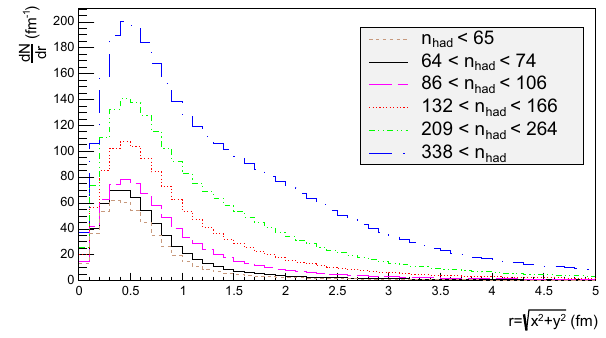
Fig. 24 Transverse spectra for 13 TeV pp collisions and different mul- tiplicity ranges